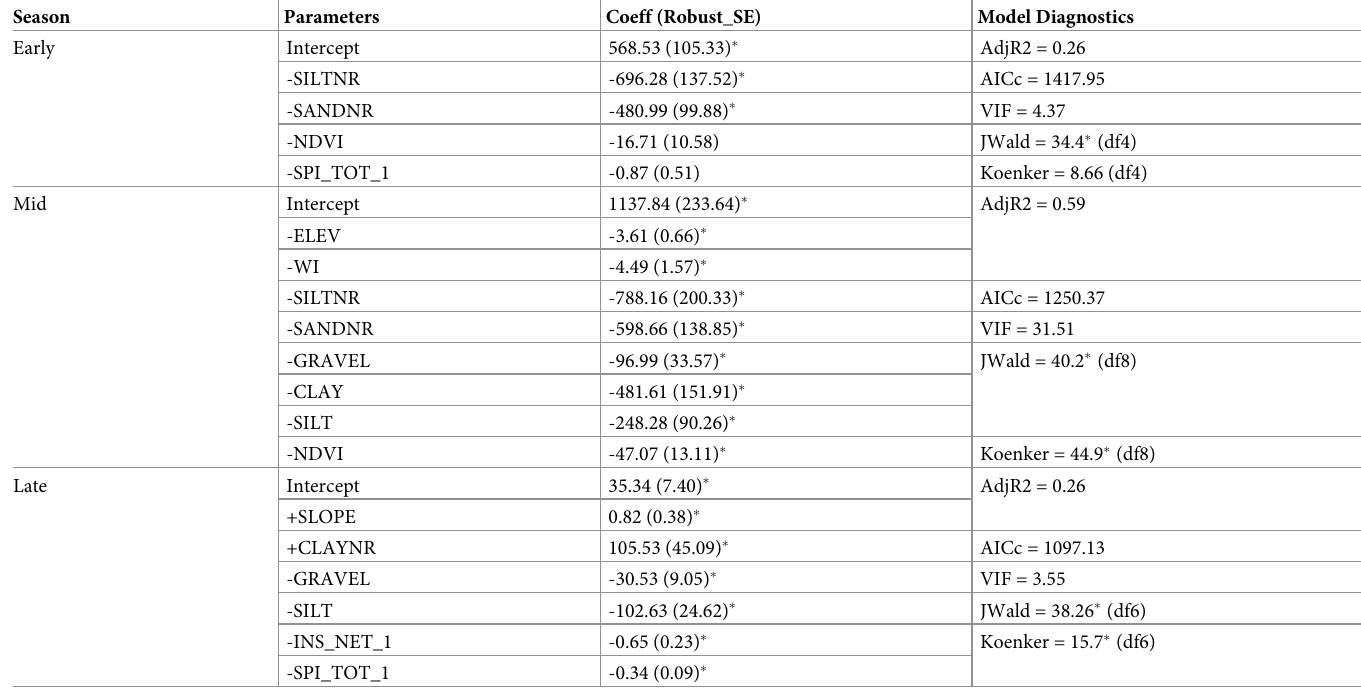
Table 10. Best fitting regression models for phloem feeder abundance early, mid, and late season, model parameters and diagnostics.